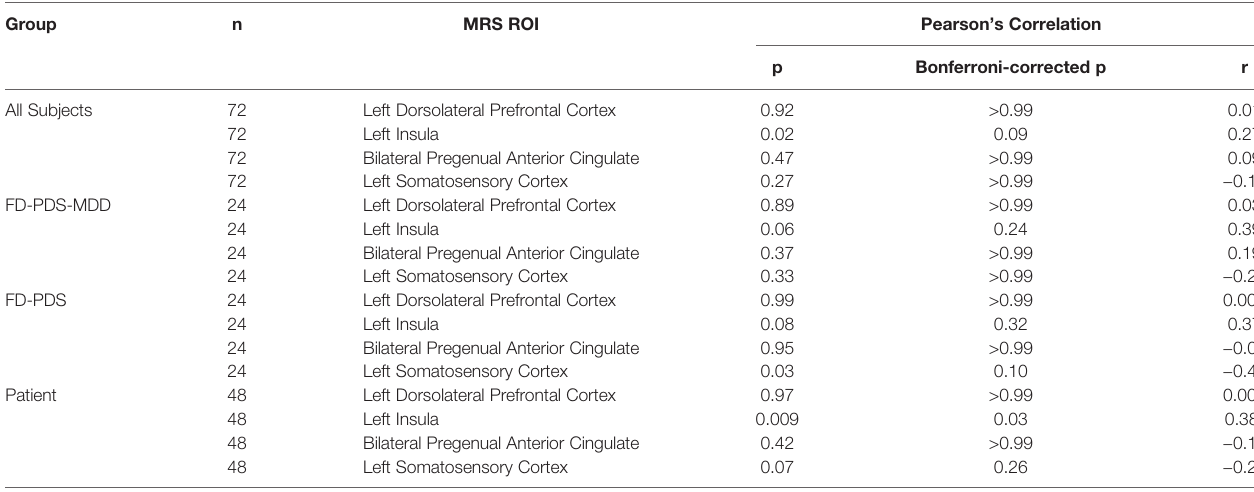
TABLE 6 | Correlations between GABA/water and same-region fALFF.